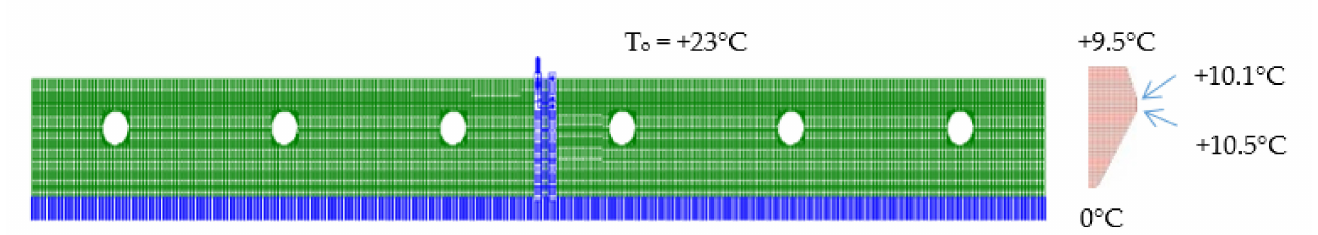
Figure 17. Model discretization with temperature actions in the floor.